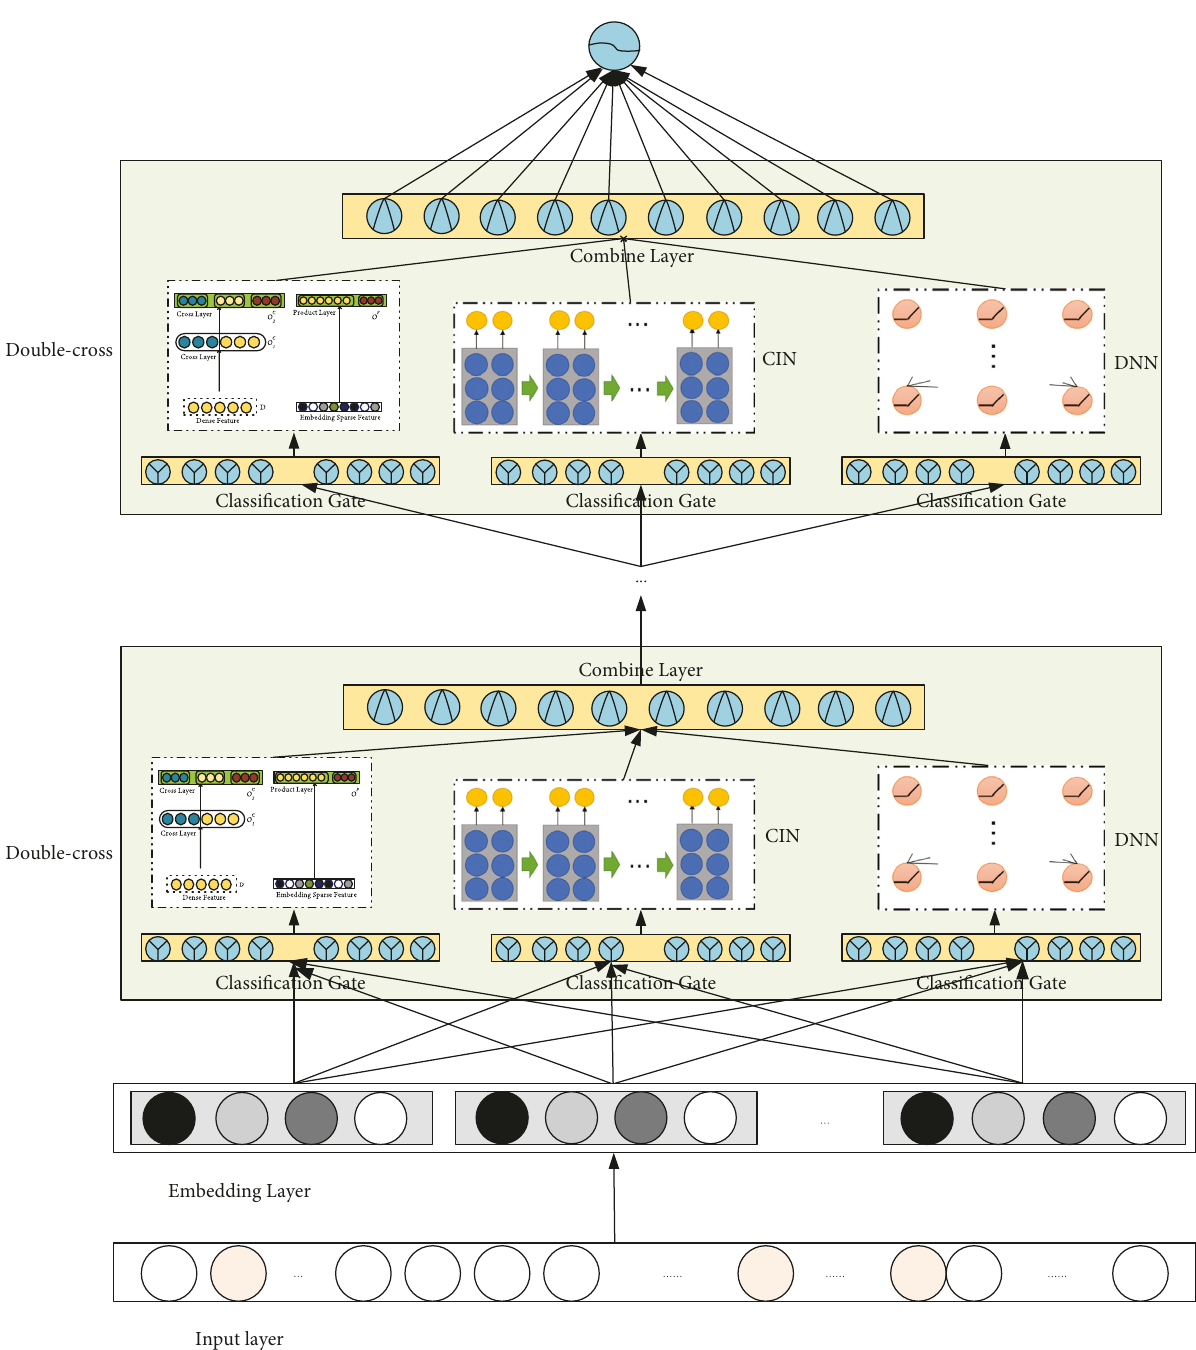
Figure 1: The CCPIN model enters three parallel submodels through the classification layer and then outputs the estimated results by merging and